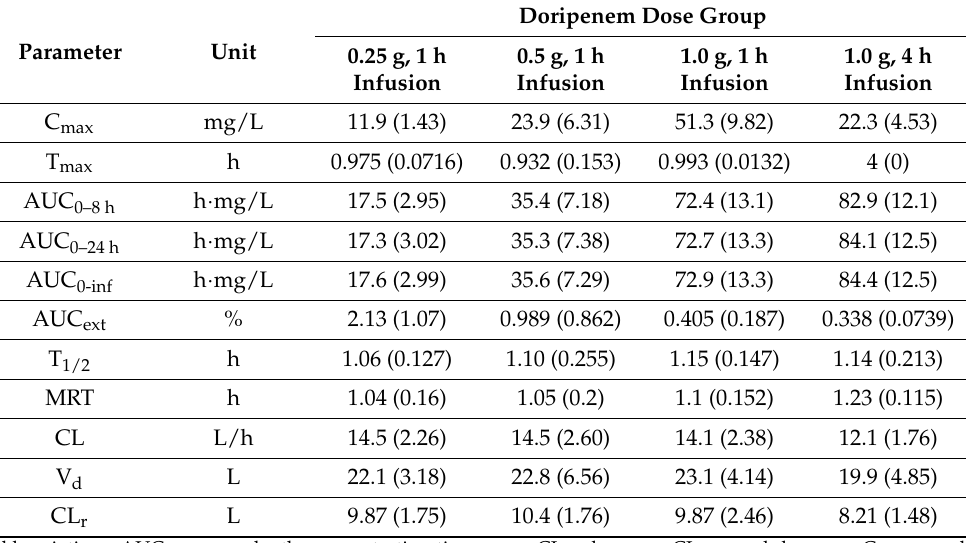
Figure 1. Mean plasma doripenem concentration-time curves after a single intravenous infusion of doripenem in healthy Chinese subjects. Symbols and error bars are the means and standard deviations from 12 subjects in each group. Table 2. Plasma pharmacokinetic parameters in healthy Chinese subjects after a single intravenous infusion of doripenem (n = 12).